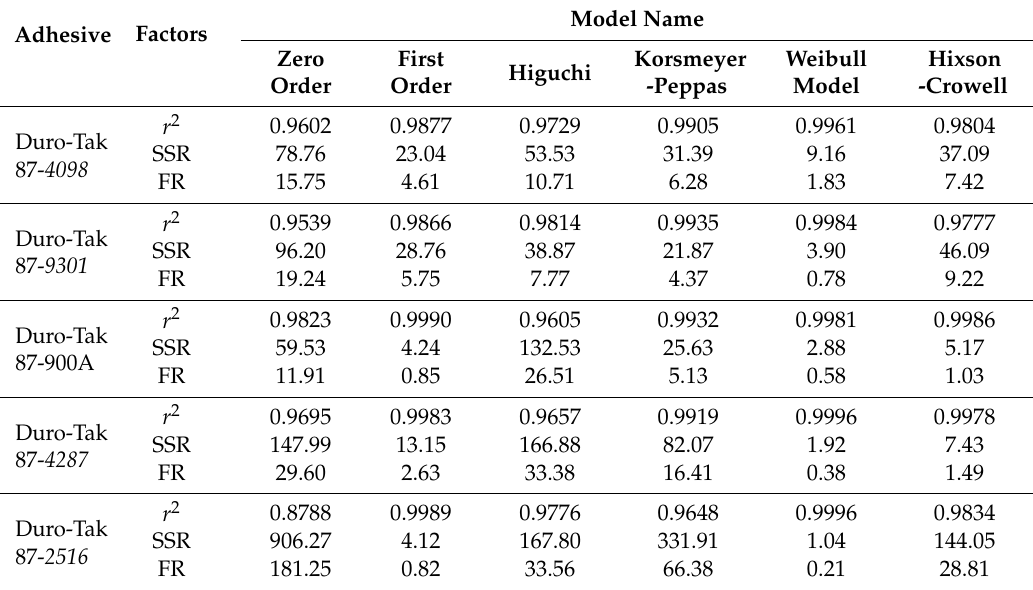
Table 2. Model fitting for drug in adhesive (DIA) pioglitazone patches with various adhesives. Adhesive